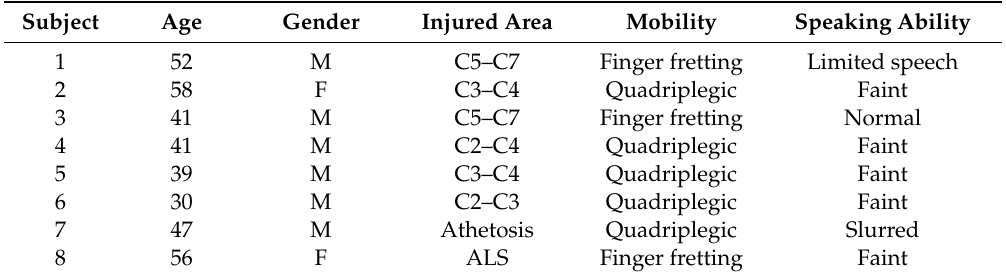
Table 1. The degree of the subjects’ barriers. ALS: amyotrophic lateral sclerosis.